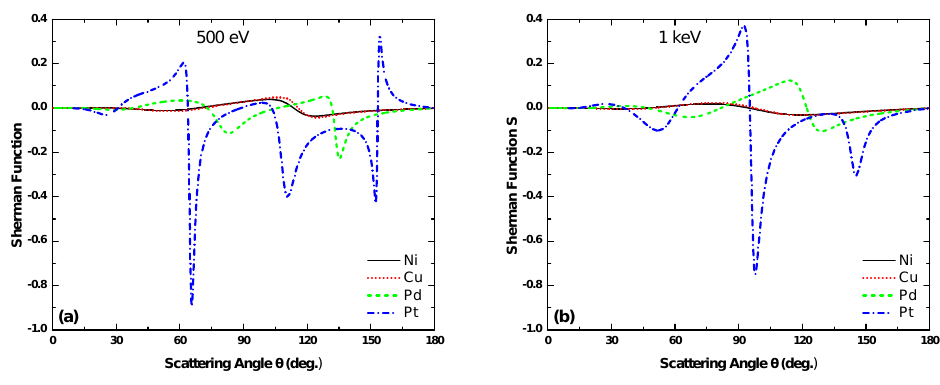
Figure 12. Angular variation of the Sherman function predicted by the OPM approach for electron scattering from Ni 58 , Cu 63 , Pd 108 , and Pt 196 at impact energies of ( a ) 500 eV and ( b ) 1 keV.